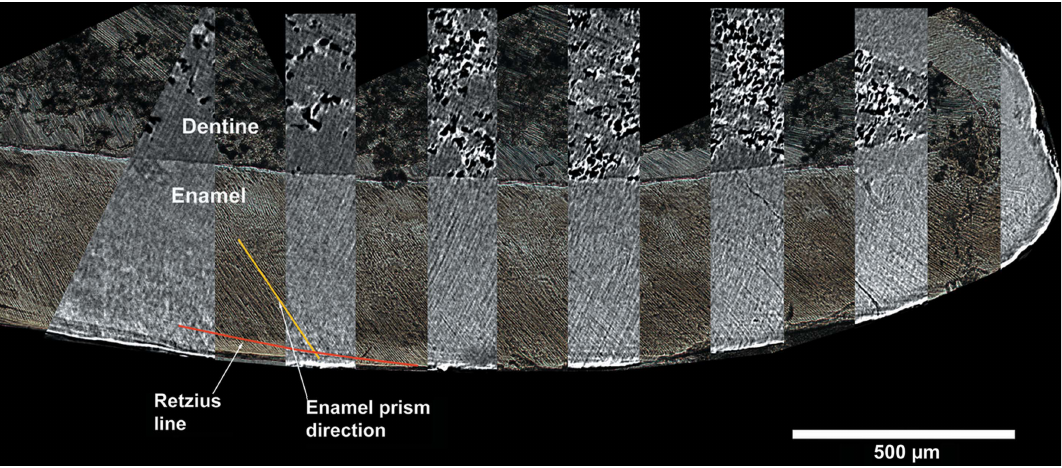
Figure 1 Velia 376 upper deciduous central incisor, superimposition of virtual histology reformatted slice portions on the classic histology image. Virtual histology: vestibular-lingual reformatted image from SR m CT, isotropic voxel size = 1.3 m m, slice thickness = 13 m m. The yellow line highlights the enamel prism direction, the red line highlights the Retzius line